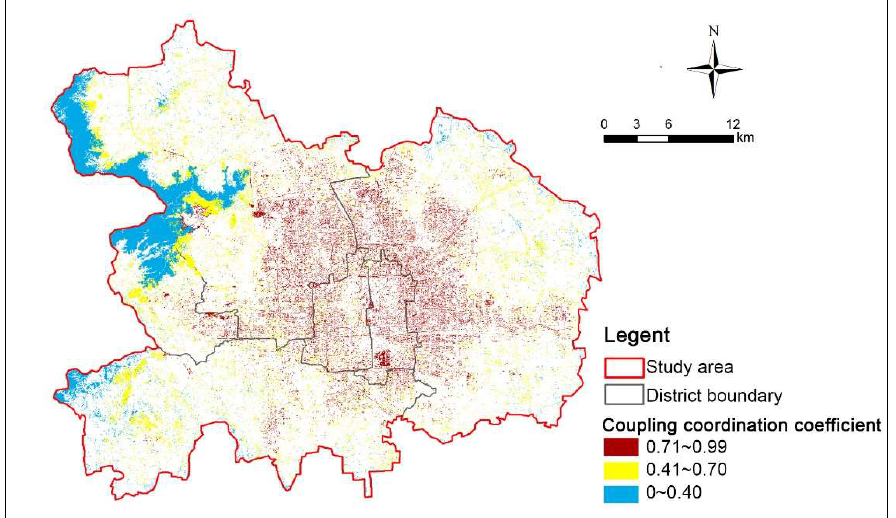
Figure 7. Spatial distribution of coupling coordination degree between urban forest biodiversity conservation and recreational services. Table 8. Statistics of different urban forest patch area thresholds for the synergy of biodiversity conservation and recreational services.